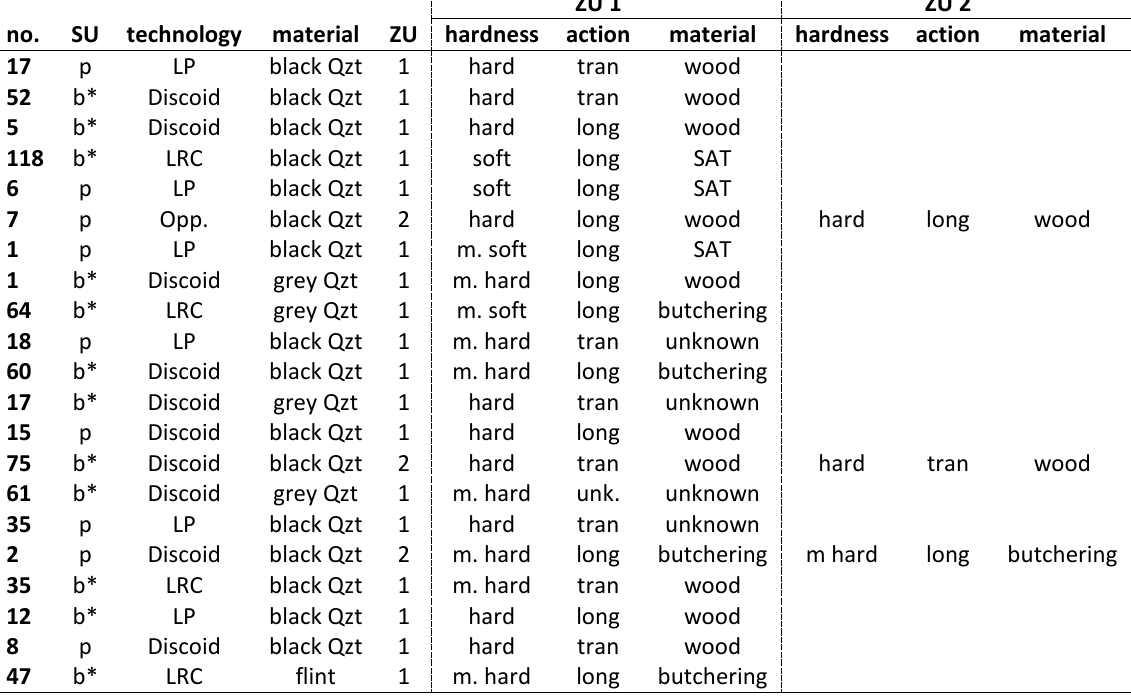
Table 4. Table with the use-wear traces found on the Lagoa do Bando artifacts Abbreviations: ZU - zone of use; SU. - stratigraphic unit; p - Layer P; b* - Layer B*; LP - Levallois preferential flake; LRC - Levallois recurrent centripetal flake ; Opp. – opportunistic flake; Qzt - quartzite; m. - medium; tran - transversal; long - longitudinal; unk. - unknown; SAT - soft animal